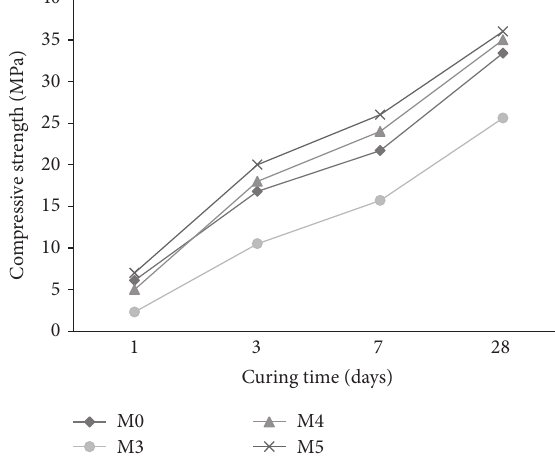
Figure 9: The effect of copolymer latexes prepared in presence of DBSS/PVA on the compressive strength of mortar.